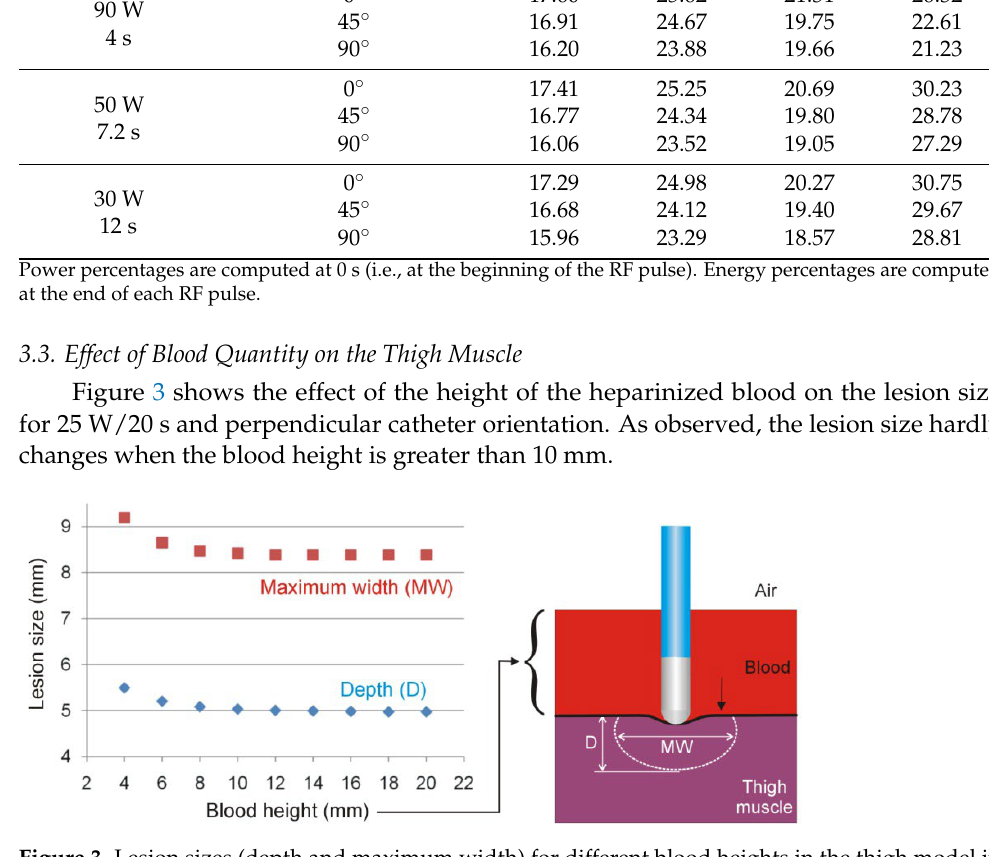
Figure 3. Lesion sizes (depth and maximum width) for different blood heights in the thigh model in the case of 25 W/20 s and perpendicular catheter orientation.